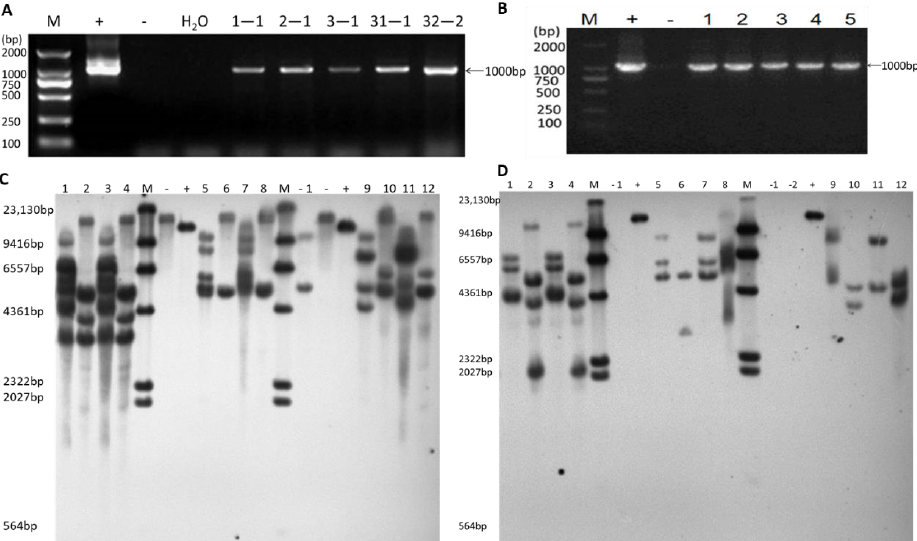
Figure 1. Schematic map of plant expression gene construct pCAMBIA3300-121-GmWRI1a. LB/RB, left/right T-DNA border sequences; BIpR, coding region of the phosphinothricin acetyl-transferase gene driven by enhanced CaMV 35S promoter; GmWRI1a, coding region of the GmWRI1a gene driven by CaMV 35S promoter.